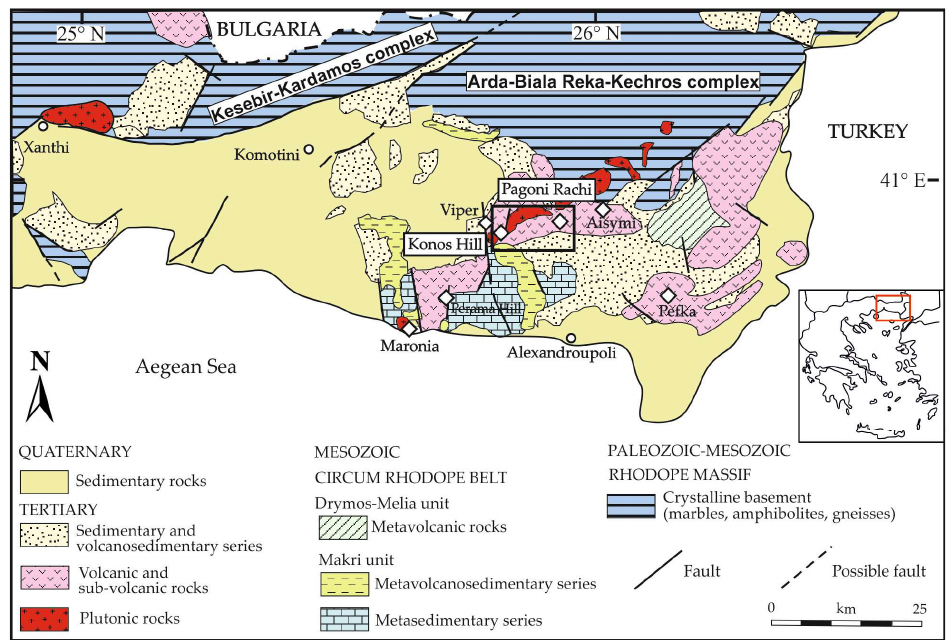
Figure 1. Simplified geological map of northeast (NE) Greece (after Voudouris et al. [48]; Mavrogonatos et al. [49]) showing the most important porphyry-epithermal deposits and prospects in the area. The black box marks the location of the study area.